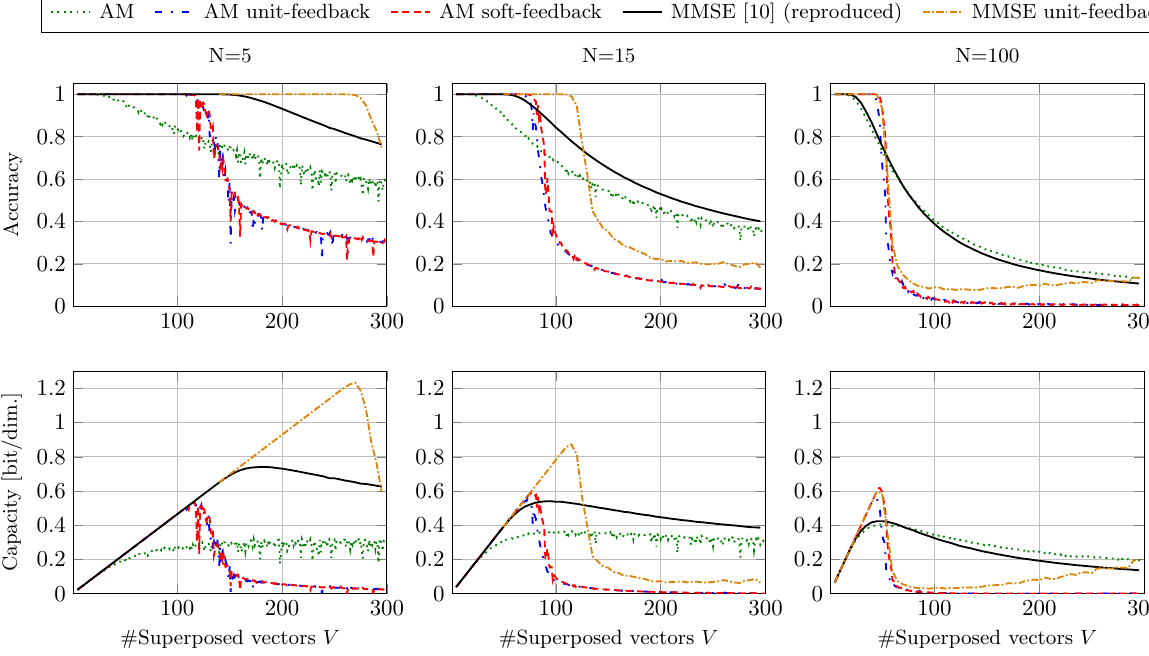
Fig. 10 Top: accuracy of correct retrieval of compressed representation of V accumulated vectors of dimension D = 500 with dictionary size of N = 5 , N = 15 , and N = 100 . Bottom: capacity derived from accuracy reported in bits per vector